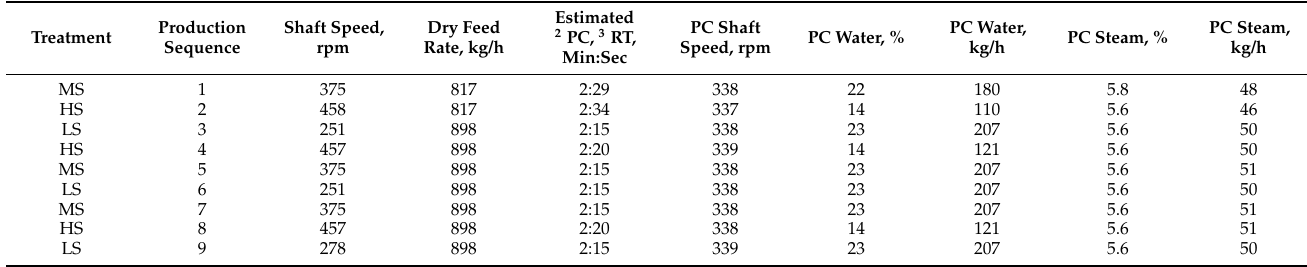
Table 2. Input parameters and production sequence of a high shear (HS), medium shear (MS), and low shear (LS) dog food extruded on a single-screw extruder.